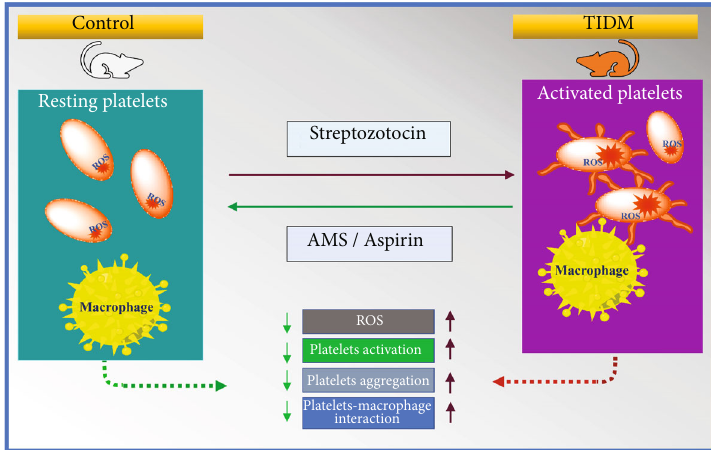
Figure 7: Attenuation of the platelet activation and platelet-macrophage interaction in type 1 diabetes by AMS. AMS: allyl methyl sul fi de; ROS: reactive oxygen species; T1DM: type1 diabetes